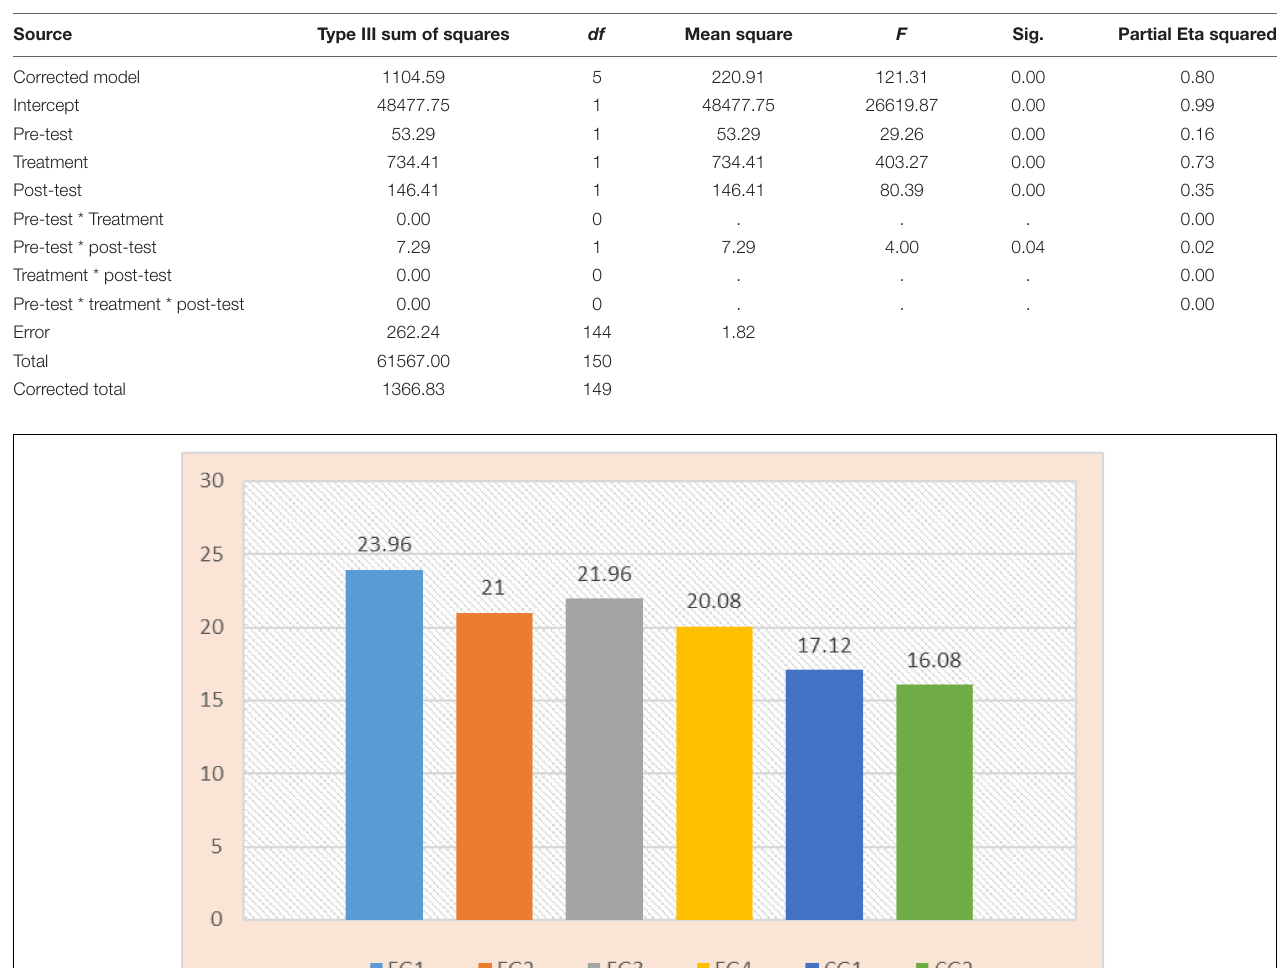
TABLE 7 | Results of three-way ANOVA for comparing the effects of ± treatment, ± pre-test and ± post-test.